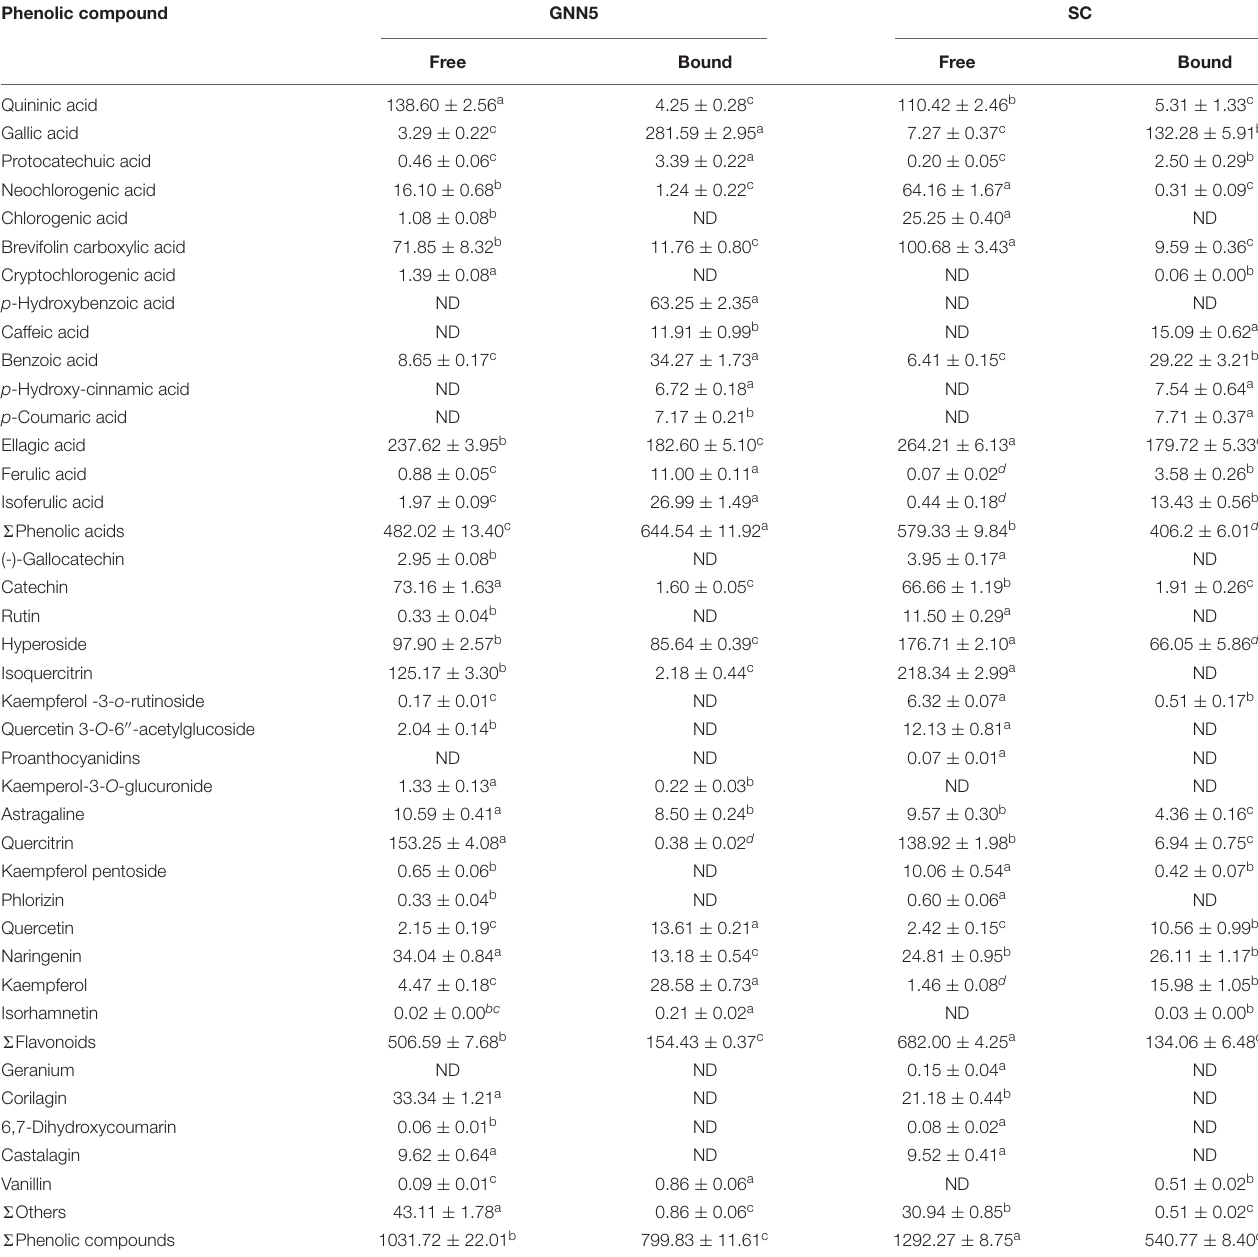
TABLE 1 | Phenolic profiles of two R. roxburghii leaves in free and bound fractions (mg/100 g DW). Phenolic